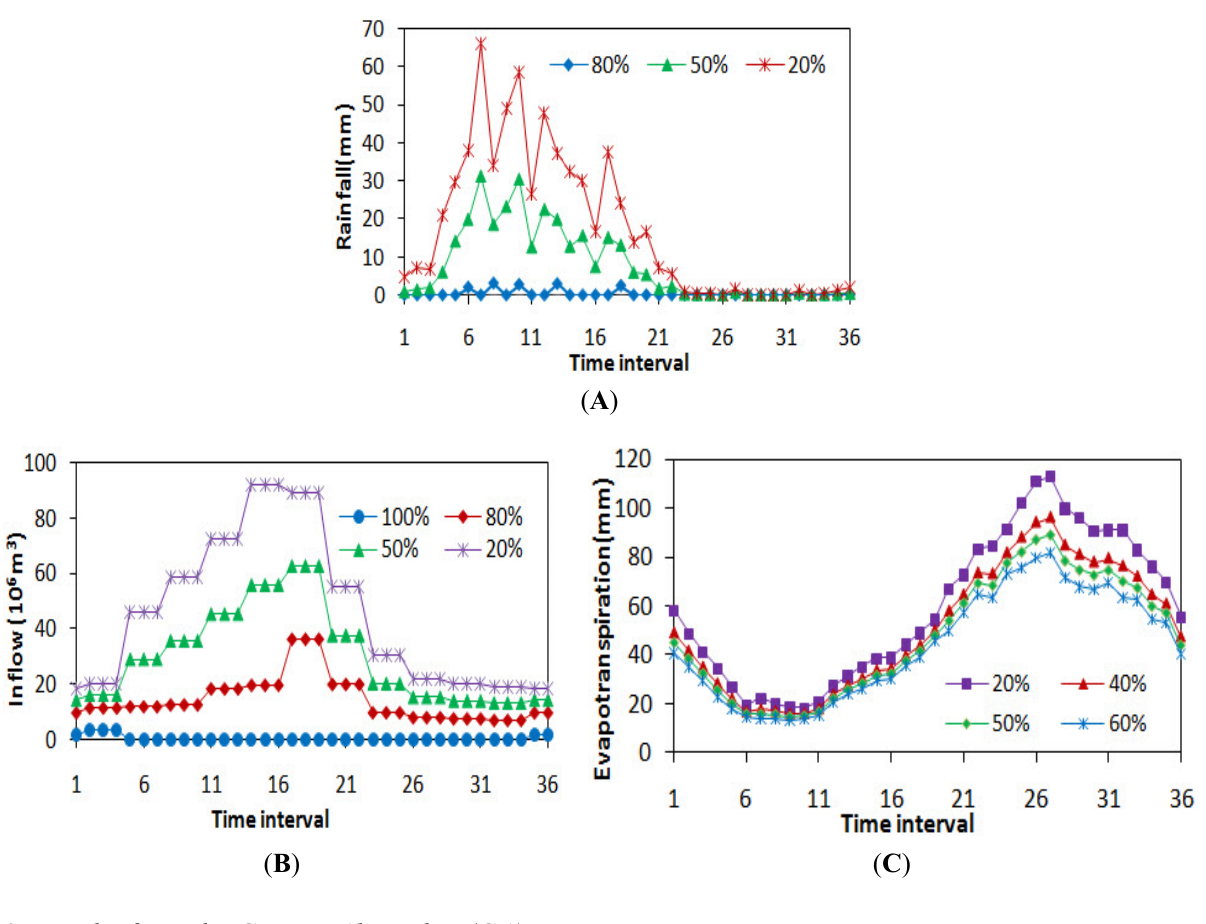
Figure 4. ( A ) Ten day rainfall levels; ( B ) Ten day evapotranspiration levels; ( C ) Ten day inflow